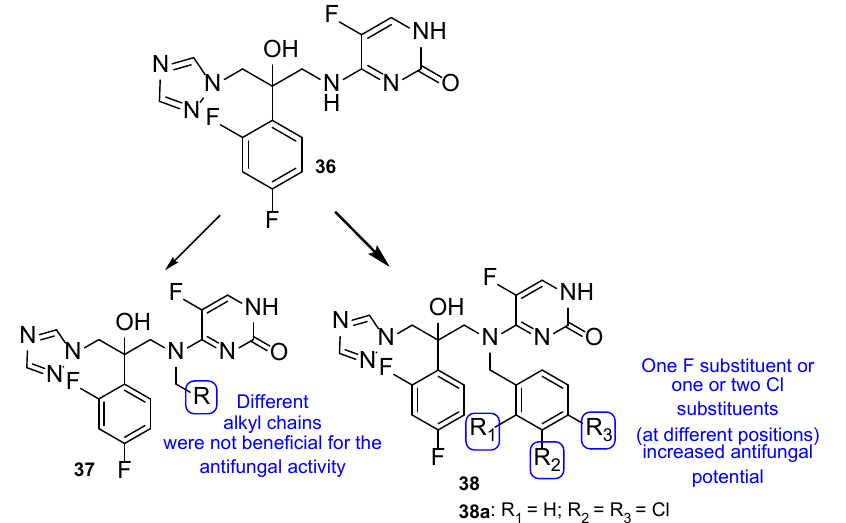
Figure 21. Chemical structure of 5-flucytosine and fluconazole hybrid ( 36 ) and of scaffolds of aryl series ( 37 ) and halobenzyl series ( 38 ), and particularly of compound 38a , and SAR for the two series [101].